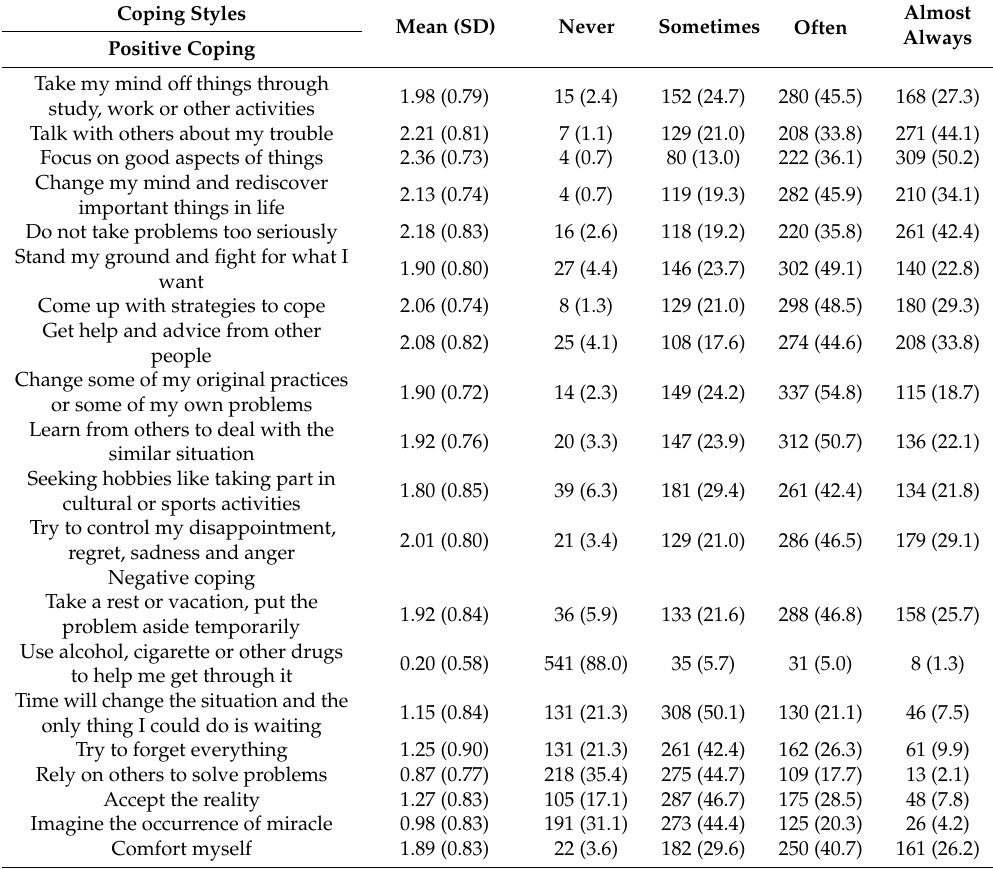
Table 2. Frequency of use of positive and negative coping styles (n =